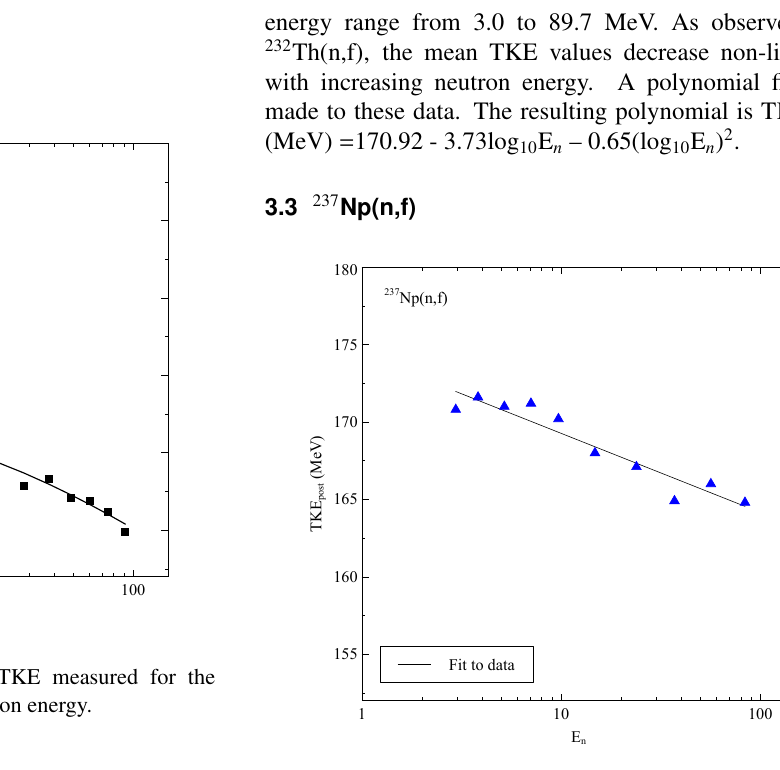
Figure 3. The average post-fission TKE measured for the 237 Np(n,f) reaction as a function of neutron